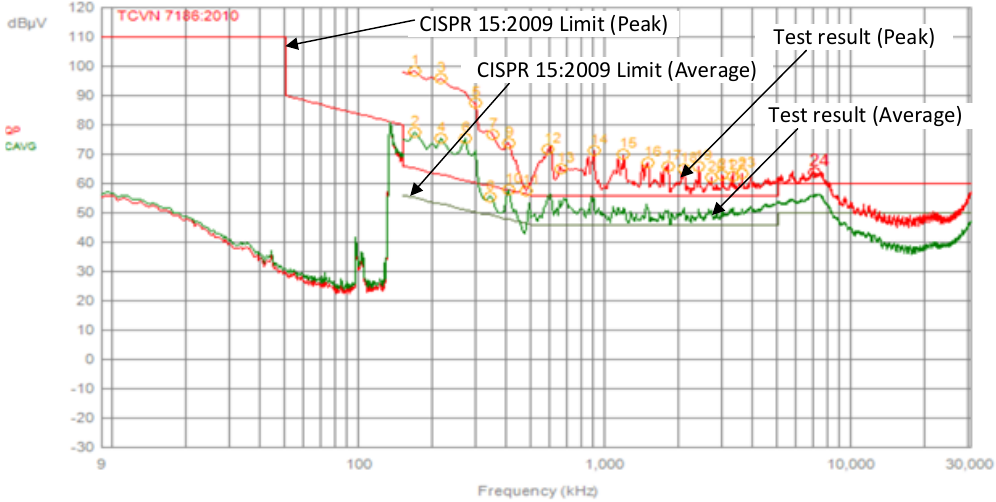
Figure 10. EMI frequency spectrum of LED driver without EMI filter and the limit of standard CISPR15:2009.